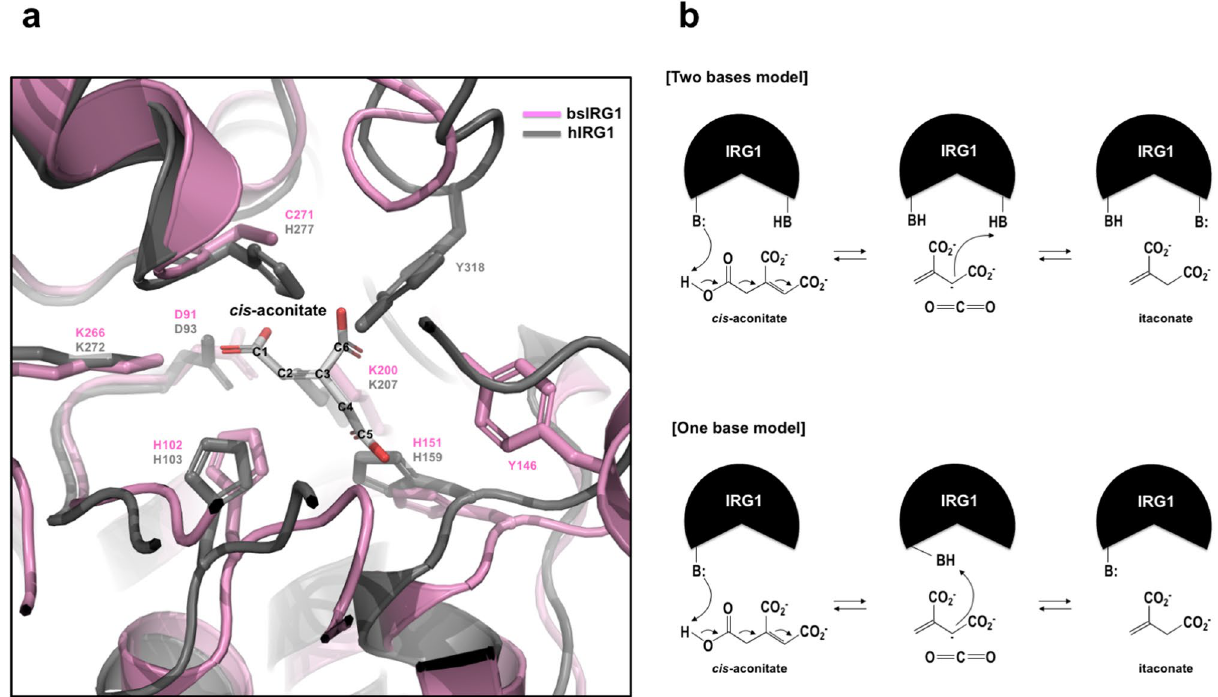
Figure 4. The potential decarboxylation mechanism of immune-responsive gene 1 (IRG1) based on structural and docking simulation analyses. ( a ) Modeling of cis -aconitate binding to the active site of Bacillus subtilis IRG1 (bsIRG1) and human IRG1 (hIRG1) derived by docking simulation analysis. ( b ) Potential reaction mechanism of IRG1. Two models, two-bases model and one-base model, are